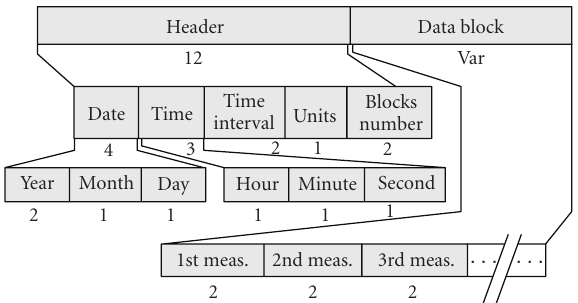
Figure 3: Overview of the data part holding the carbon dioxide data (Section-202).